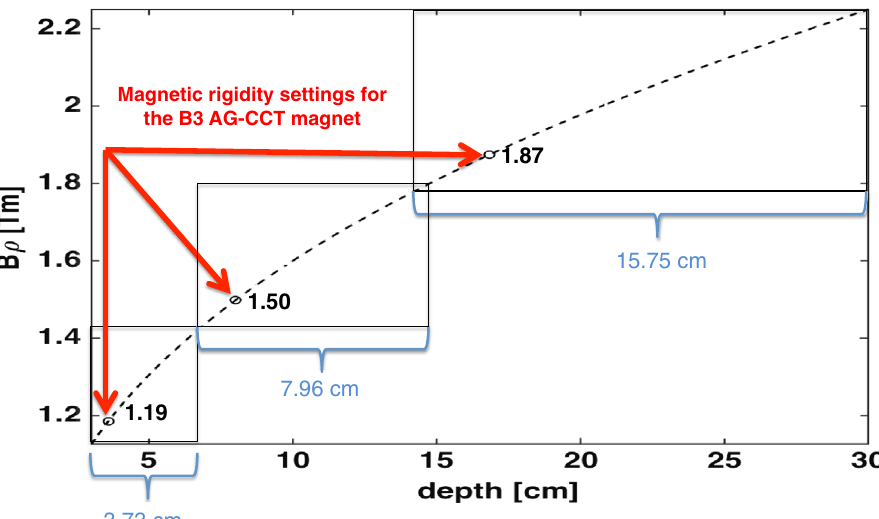
FIG. 18. This is an illustration that with a 25% momentum acceptance three settings allow one to cover the range of 4 to 30 cm.